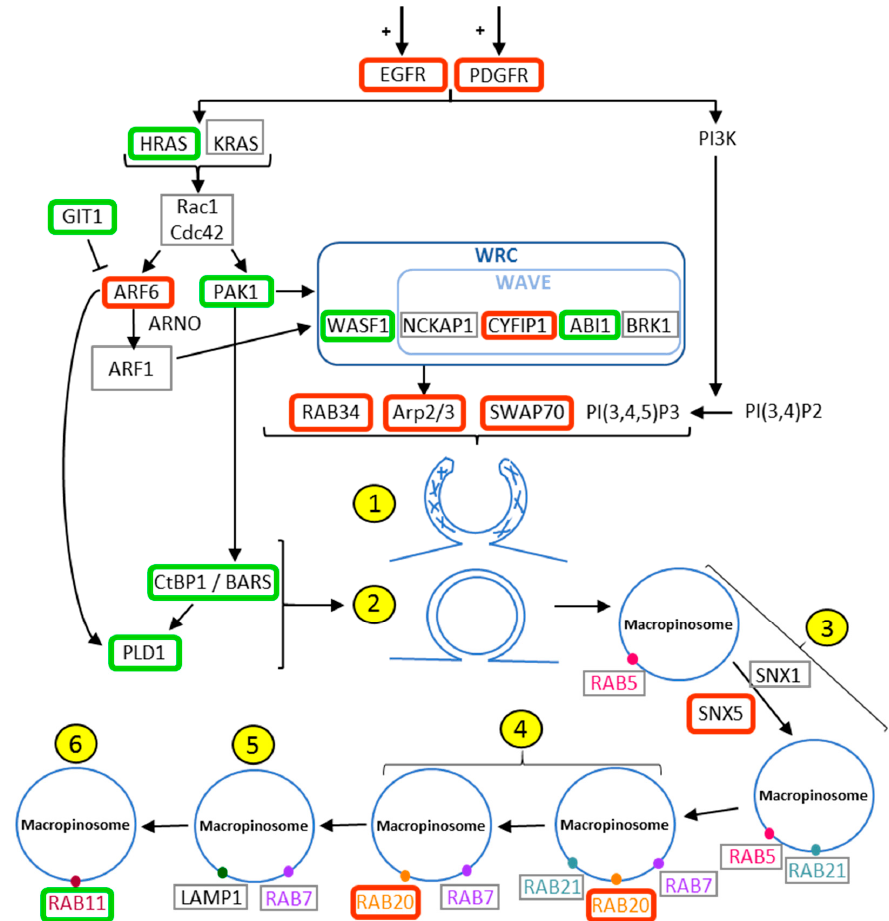
Figure 2. Macropinocytosis process and its deregulation in glioma. Upregulated genes are framed in red, downregulated ones in green, and those genes for which no change was observed are framed in grey. The stimulation of EGFR and PDGFR induces the activation of K-Ras and H-Ras. These Ras GTPases activate both Arf6 and Pak1 to initiate the actin polymerization. Arf6 recruits ARNO (Arf guanine nucleotide exchange factor) for the activation of Arf1 to enable the WAVE regulatory complex (WRC), composed by Wasf1 and the WAVE complex, which regroups Nckap1, Brk1, Cyfip and Abi1. WRC activates Arp2/3, which induces actin branch formation and actin polymerization (1) for the formation of macropinosomes with the help of Rab34, Swap70 and PI(3,4,5)P3. Both Ctbp1 (activated by Pak1) and PLD1 (activated by Arf6 and Ctbp1) are essential for the closure of the macropinocytic cup and the final fission from the plasma membrane (2). Rab5 is a marker of early endosome as well as Rab21, which remains on the intermediate endosome (3). SNX1 and SNX5 play a role in macropinosome maturation (3). Markers of intermediate endosomes are Rab21, Rab20 and Rab7 (4). Rab7 is also a marker of late endosome as well as Lamp1 (5). Rab11 is a marker of endosome recirculating to the plasma membrane (6).